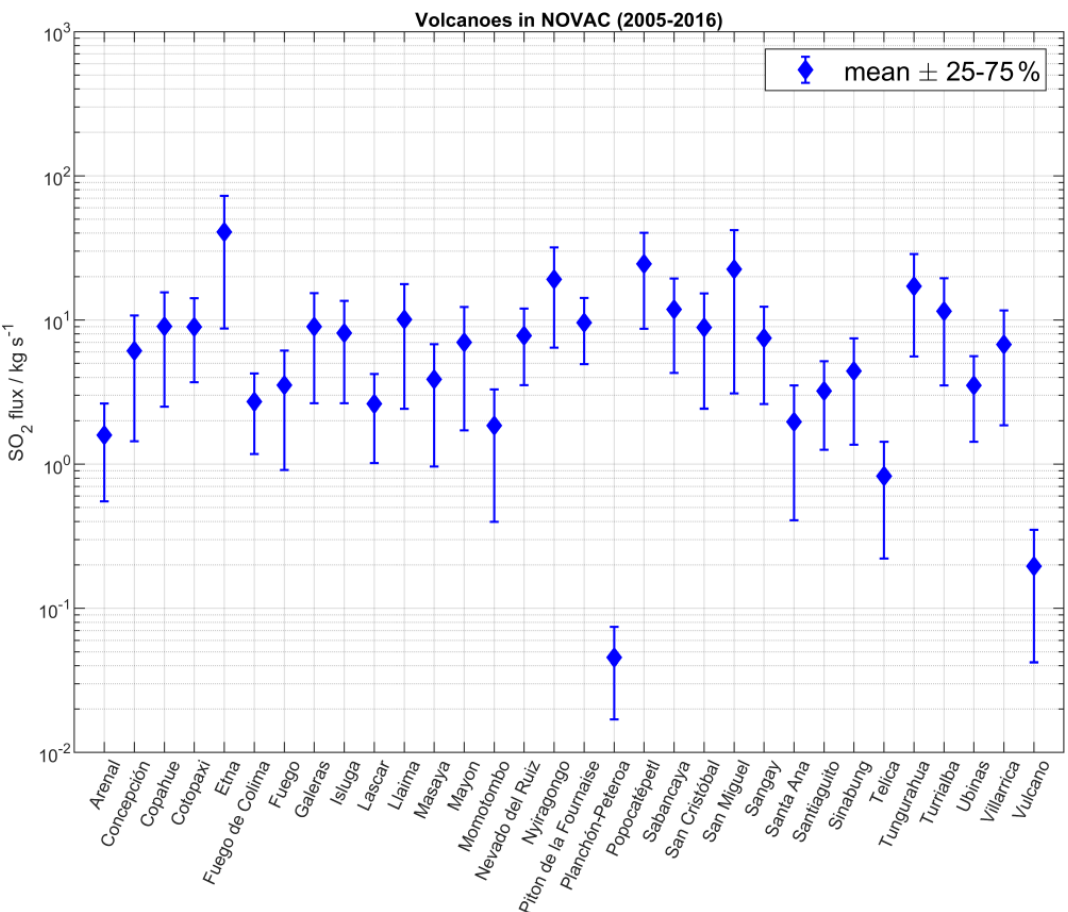
Figure 4. Statistics of daily SO 2 emission from 32 volcanoes in NOVAC from 1 March 2005 to 31 January 2017, for periods of time when data were being collected and yielding flux values above the detection limit. Blue markers show the average of all measured fluxes for each volcano during this period, and the error bars show the corresponding 25% and 75% quantiles.